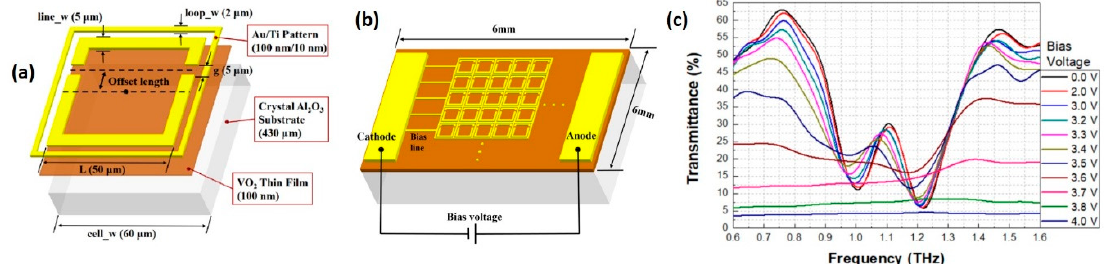
Figure 4. Insulator-metal transition (IMT) controlled by integrated micro-heater. ( a ) Schematic of the asymmetric split-loop resonator with outer square loop (ASLR-OSL) based on VO 2 and ( b ) configuration of a bias engagement for the electrical active-control of the ASLR-OSL. ( c ) Frequency responses with increasing bias voltage. Polarization of THz waves is parallel to the gap. Reproduced from [32], with permission from Optical Society of America 2018.